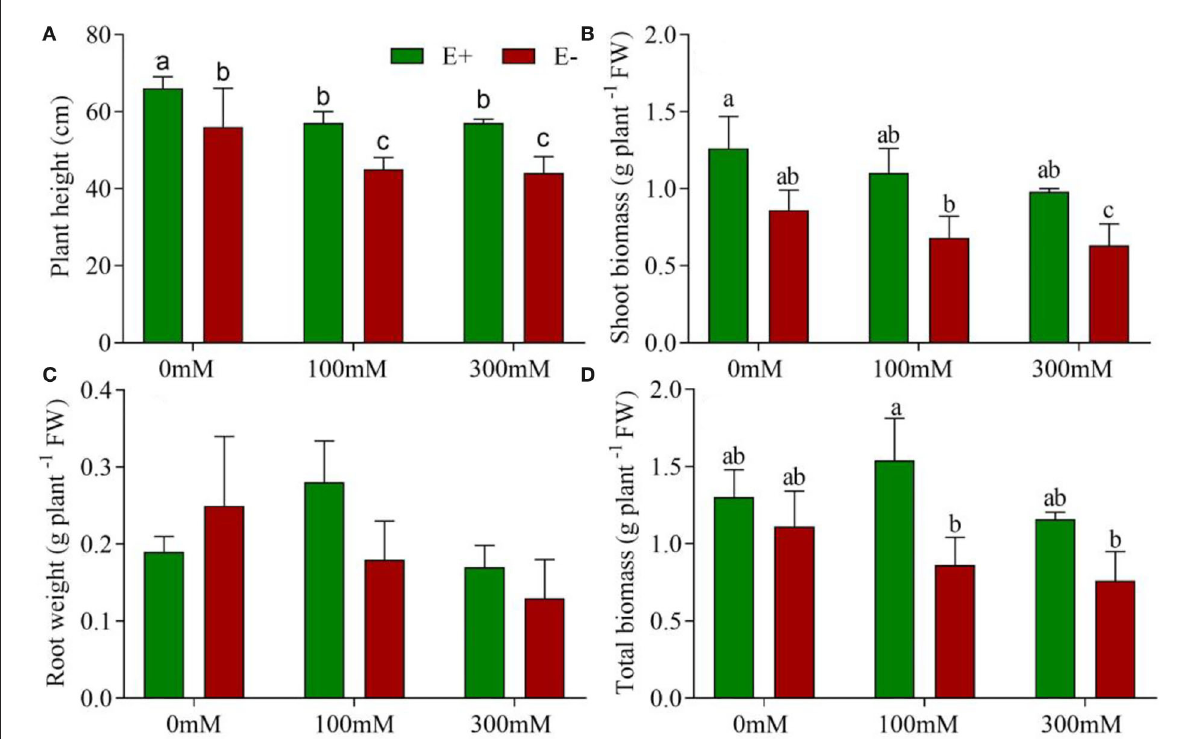
FIGURE1 E. bromicola enhances barley growth under salt stress conditions. Plant height (A) , shoot biomass (B) , root biomass (C) , and total biomass (D) of barley affected by E. bromicola inoculation and subjected to 0, 100, and 300mM NaCl (values are means ± SE). Green bars represent E + barley, and red bars represent E– barley. Measurements were carried out after 21 days of plant growth under salt stress. Different letters indicate significance at a p -value < 0.05 among treatments (Tukey’s test). FW = fresh